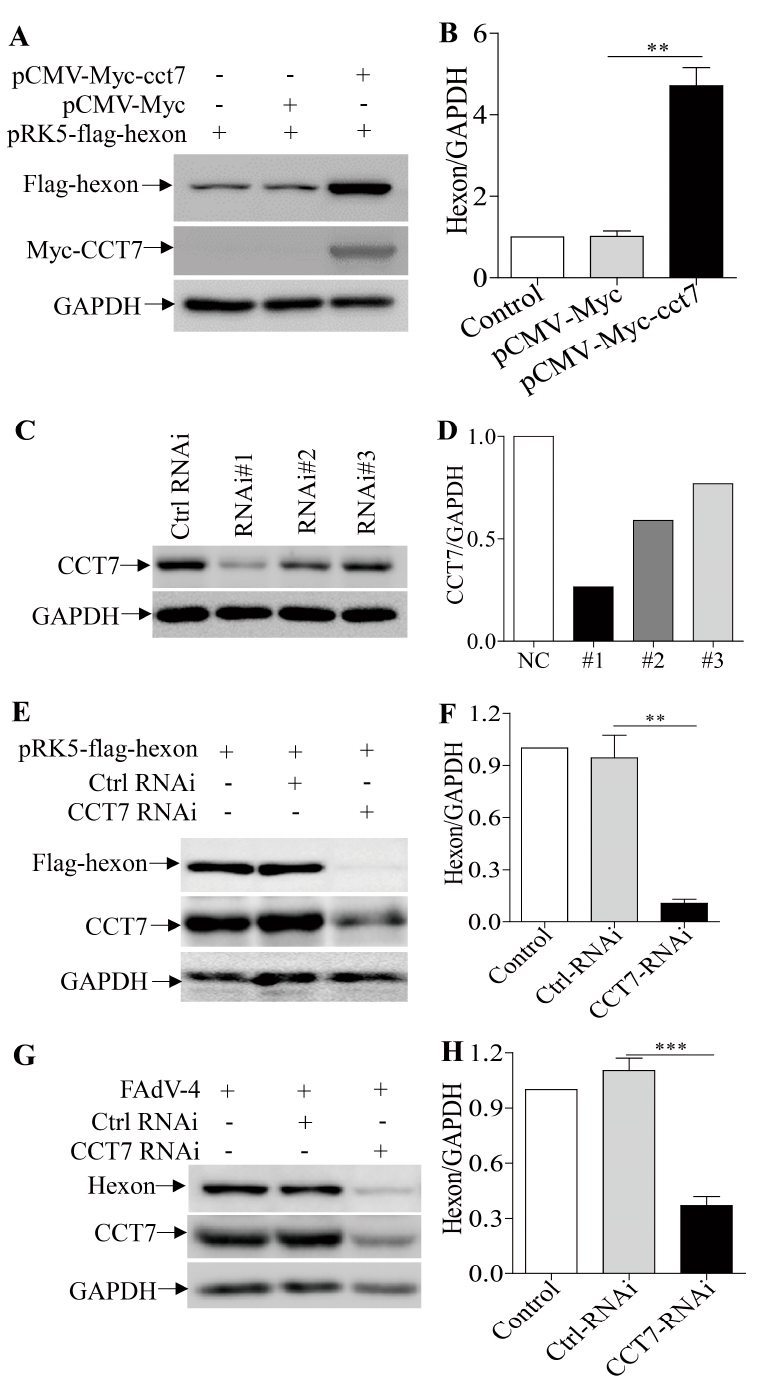
Figure 6. CCT7 is required for the presence of hexon. ( A , B ) Overexpression of CCT7 enhanced hexon levels in cells transfected with pRK5-flag-hexon. LMH cells were transfected with the indicated plasmids; twenty-four hours after transfection, the cell lysates were prepared and examined by Western Blot ( A ). The levels of hexon in ( A ) were quantified by densitometry and normalized to that of GAPDH ( B ). The level of hexon in controls was set at 1.0. ( C , D ) Effects of CCT7 RNAi on the expression of endogenous CCT7. LMH cells were transfected with siRNA (RNAi#1-3) or controls. Twenty-four hours after the second transfection, cell lysates were prepared and examined by Western Blot using anti-CCT7 antibodies ( C ). Endogenous GAPDH was used as an internal control. The density of bands in ( C ) was quantitated by densitometry as above described ( D ). ( E , F ) knockdown of CCT7 reduced hexon expression in cells. LMH cells were treated with CCT7 RNAi or control RNAi and transfected with pRK5-flag-hexon ( E